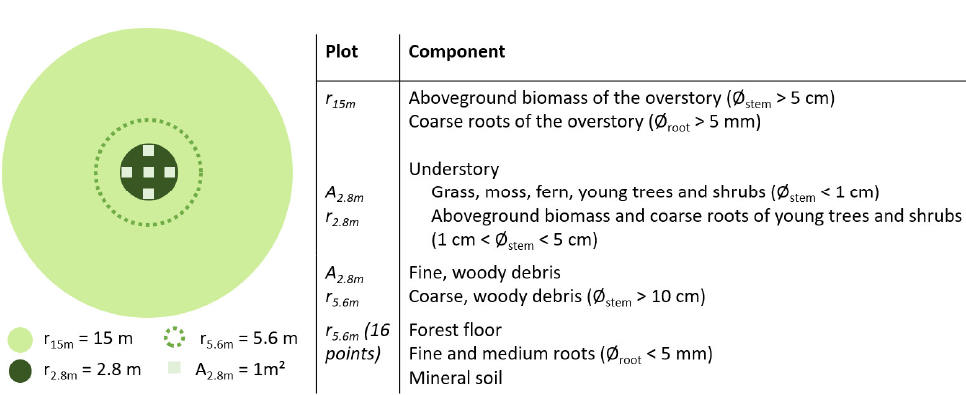
Figure 2. Overviewofthedifferentmeasuringplotsandthecomponentsmeasured. Øindicatesthe Figure 2. Overview of the different measuring plots and the components measured. Ø indicates the diameter